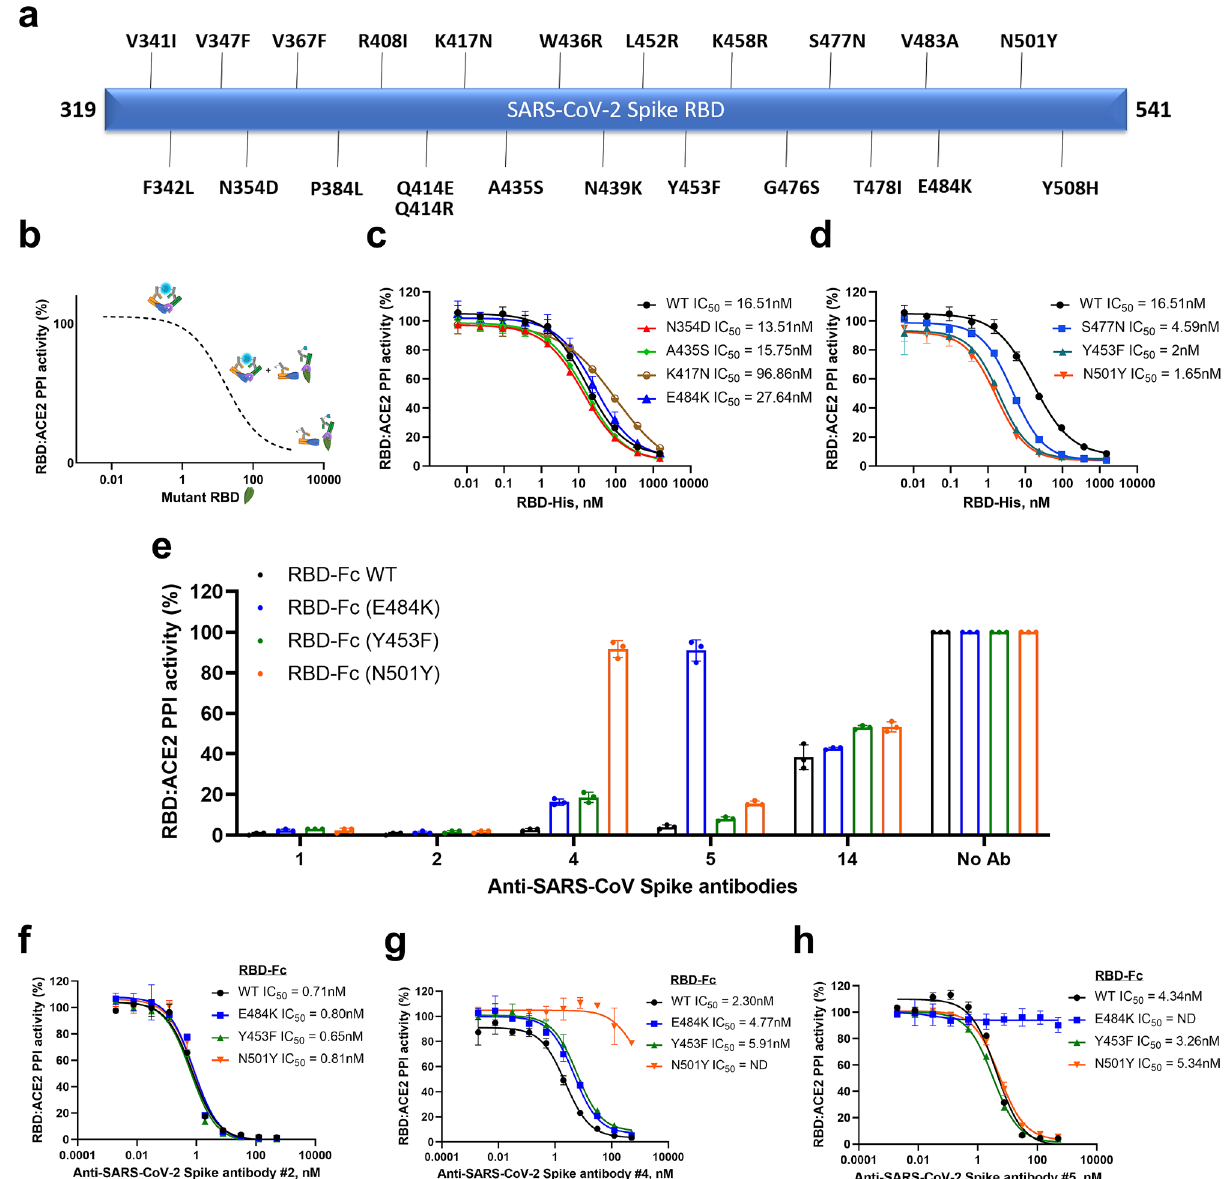
Figure 4. Effect of RBD mutations on Spike RBD:ACE2 binding. ( a ) Schematic diagram showing SARS-CoV-2 Spike RBD mutations evaluated in this study. ( b ) Rationale of the competition assay used for evaluation of RBD mutations. RBD-His mutants were evaluated in dose response experiments, and IC 50 values generated were compared with wild type RBD-His. ( c , d ) RBD-His WT and mutants were serially diluted and incubated with hACE2-mouse Fc for 30 min prior to the addition of RBD-rabbit Fc and Lumit antibodies. ( e ) Antibody screening using wild type RBD-Fc and variants containing the E484K, Y453F or N501Y mutations. ( f – h ) Antibody titrations with RBD-Fc WT and mutants. Results are presented as means ± S.E.M. (n = 3 technical replicates, the data are representative of two or more